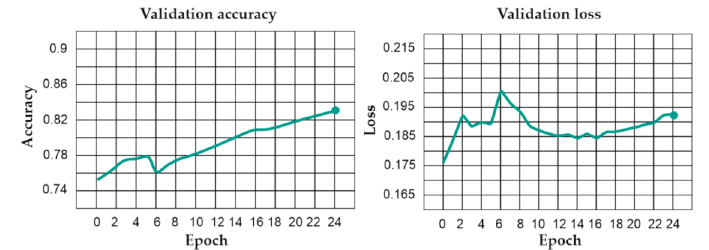
Figure 6. U-Net training validation.